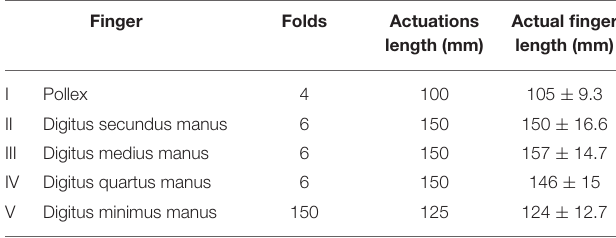
TABLE 1 | Dimensions of FFAs used in this